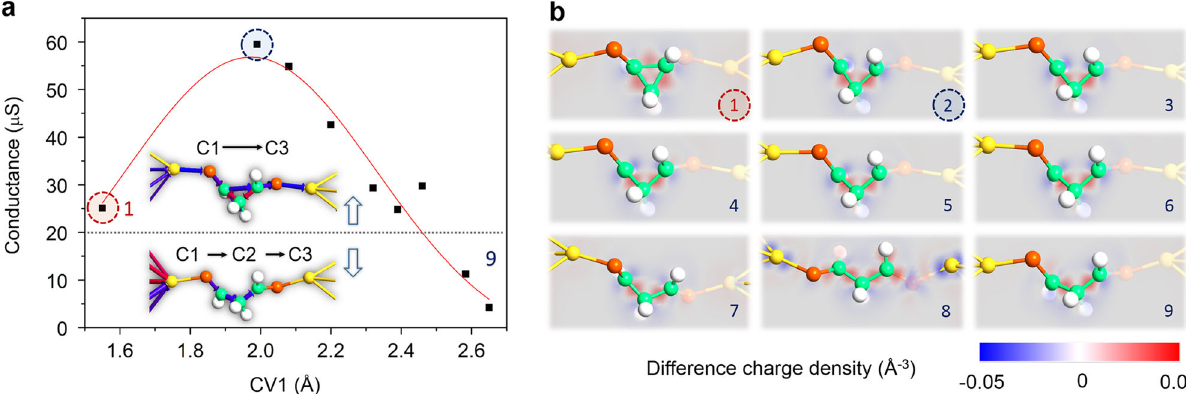
Fig. 5 Relationship between the bond break and the conductance change of SMJ. a The conductance change during the distance of C1 – C3 extends from 1.6 to 2.6 Å. The conductance increases from 1.6 to 2.0 Å decreases from 2.0 – 2.6 Å. The inset shows the changes in transmission pathway (contributions from the left eletrode). For points above the blue dashed line , the pathway is C1 → C3; for points beneath the line, the pathway is C1 → C2 → C3. b The difference charge density change from snapshot 1 to snapshot 9